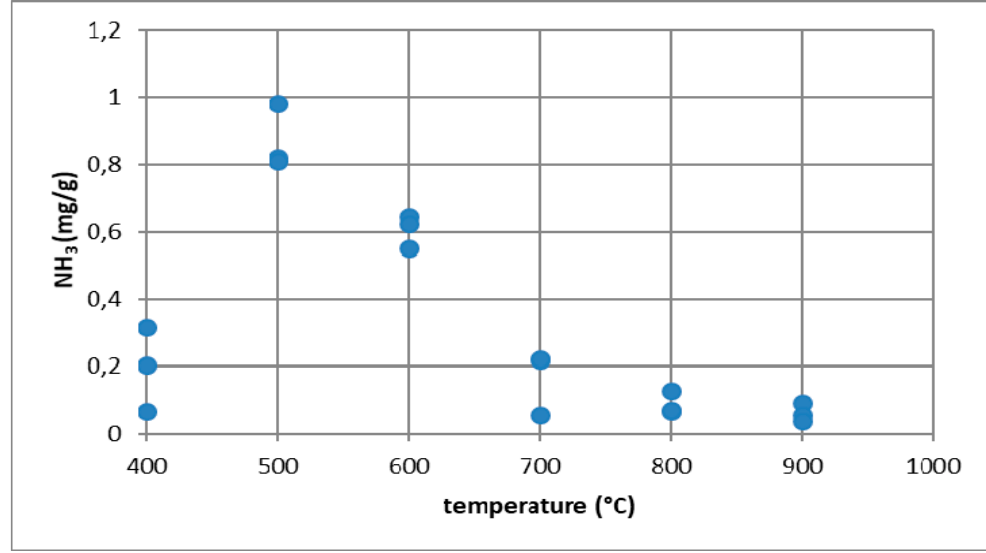
Figure 17. Ammonia emissions from the coal combustion process.